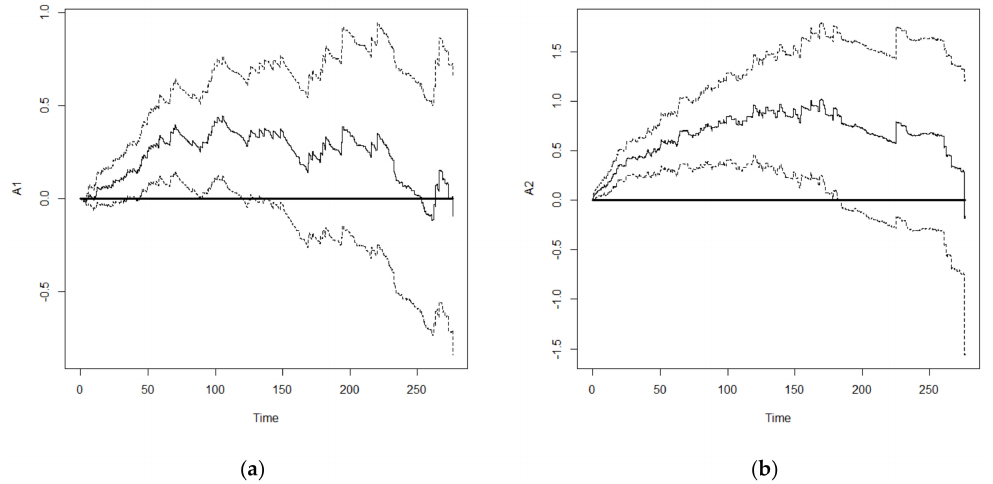
Figure 3. Cumulative regression coefficient and 95% confidence interval: ( a ) Slight ADL; ( b ) Poor self-rated health